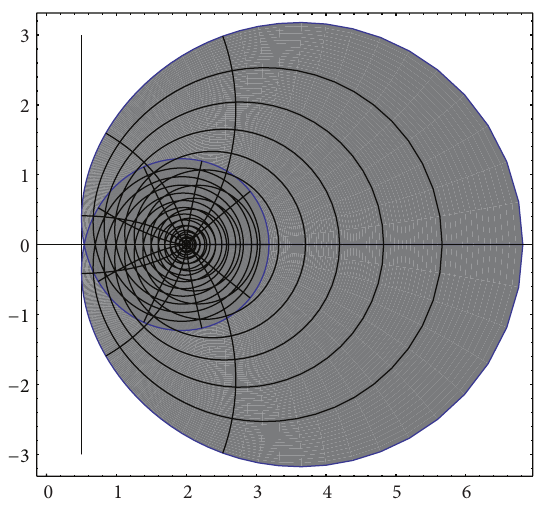
√3 − √6 touches Re 𝑤 = 0.5 .